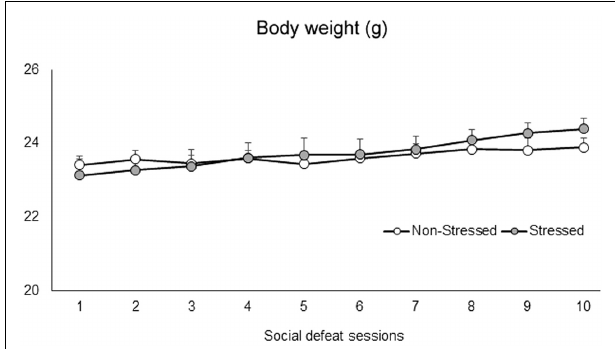
FIGURE 2 | Body weight (g) of non-stressed controls and socially defeated mice. Control non-stressed mice were weighed daily, while stressed mice were weighed and then socially defeated for ten consecutive sessions. Data are mean ± SEM. n = 36 − 37 mice per